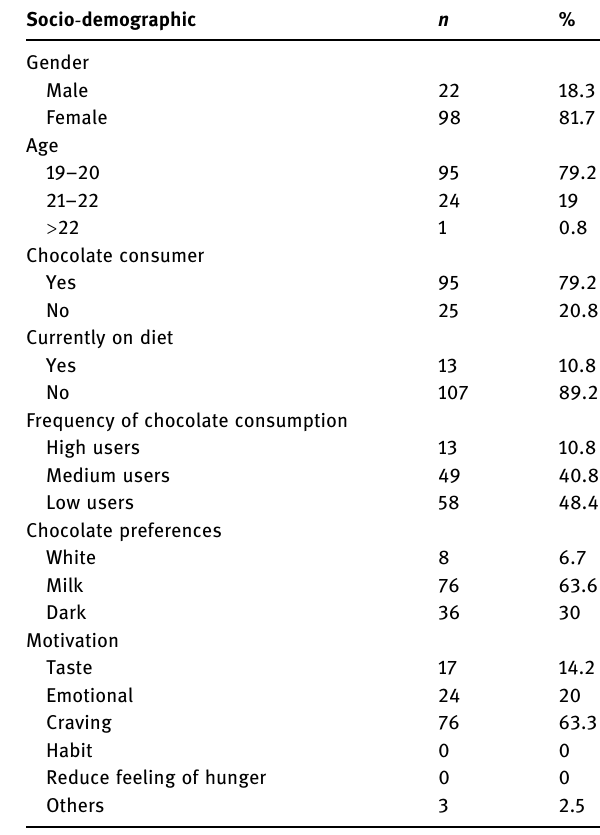
Table 3: Socio - demographic and chocolate consumption behaviour of